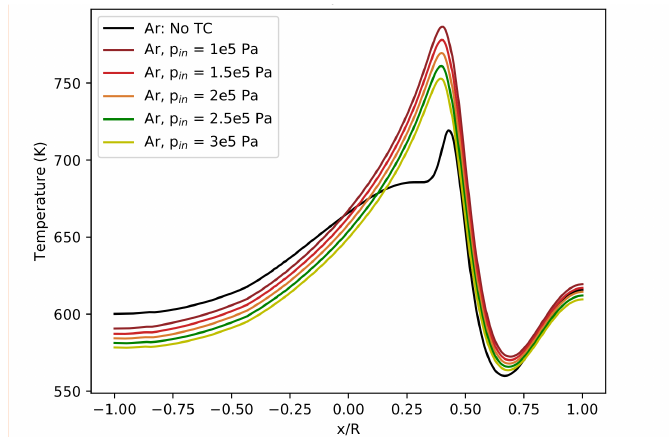
Figure 7. Temperature variation along wall for Mach 10 argon flow when coolant plenum pressure is varied (TC = transpiration cooling).